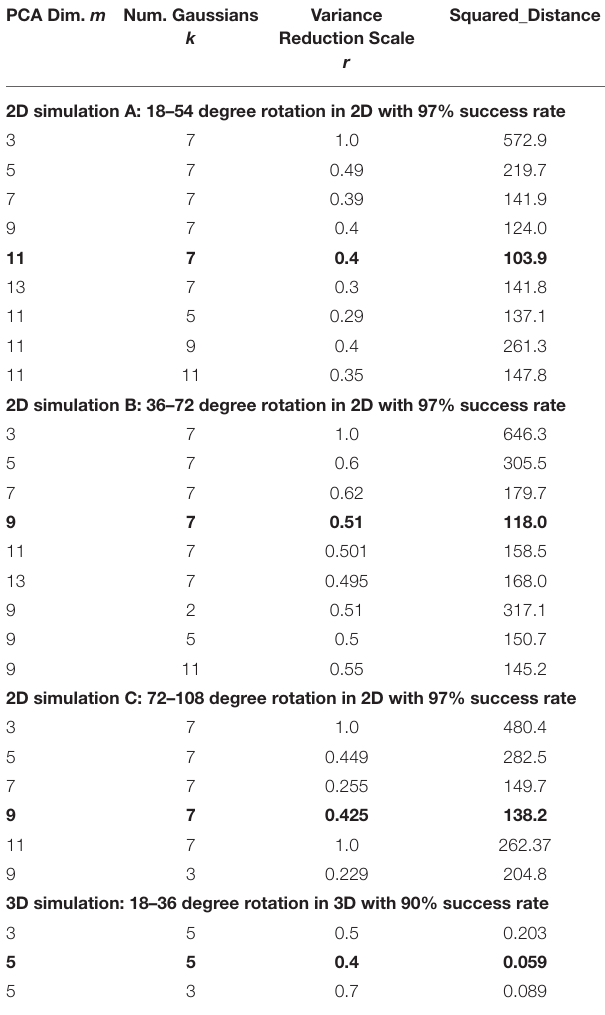
TABLE 2 | Simulation results identifying the best